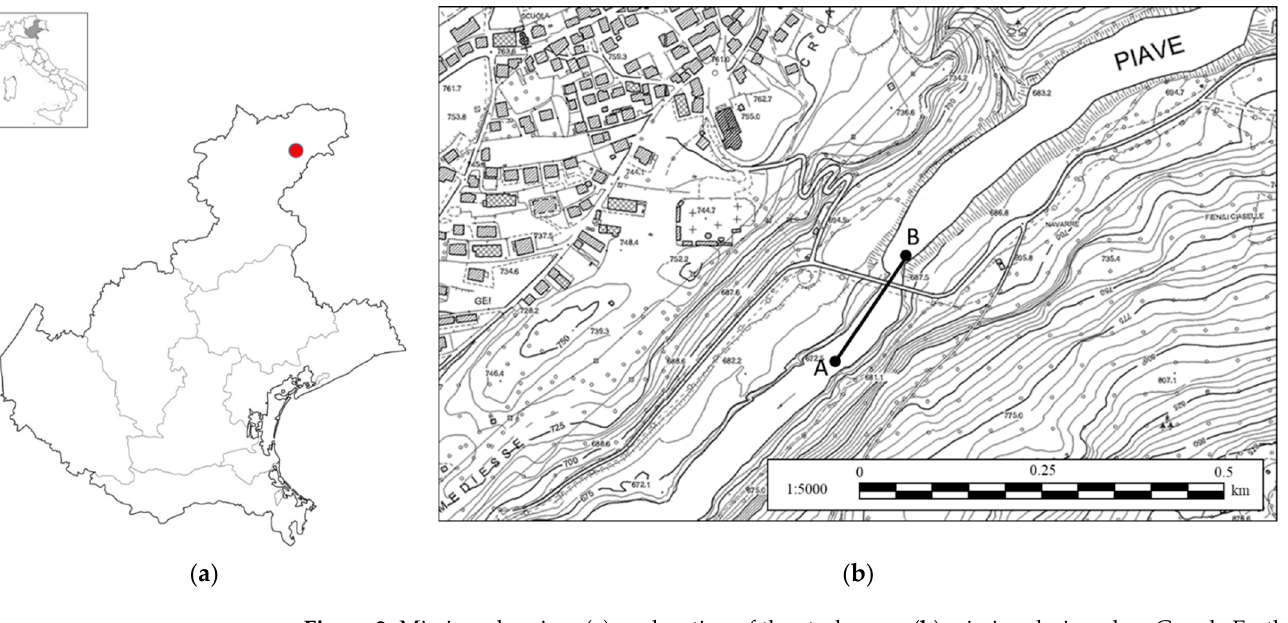
Figure 2. Mission planning: ( a ) geolocation of the study area; ( b ) mission designed on Google Earth in order to move the UAV from point A to point B.